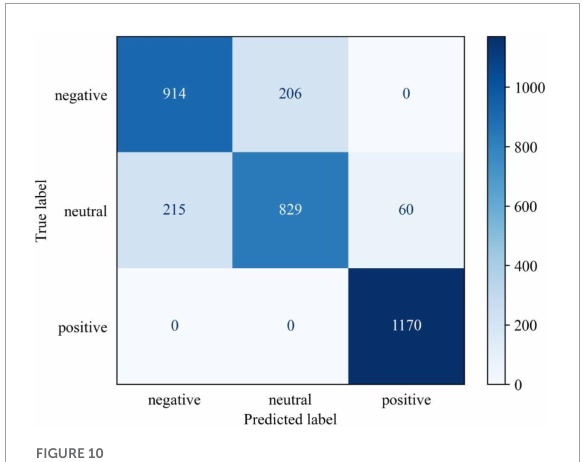
FIGURE10 The confusion matrix of predictions in a cross-subject transfer